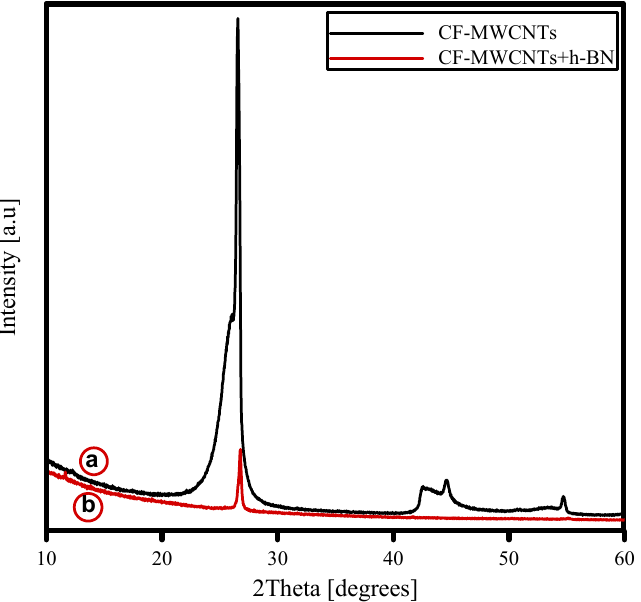
Figure 3. XRD diffraction of (a) CF-CNTs and (b) hBN / CF-CNTs water-based nanofluids.